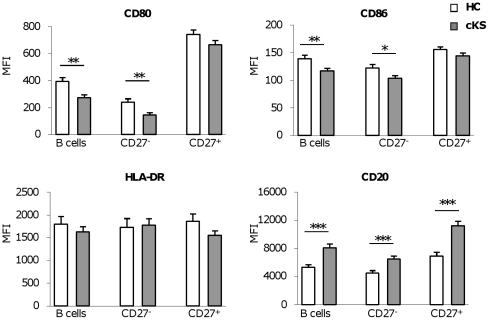
B cells from cKS patients show a low state of activation.B cells from cKS patients (grey bars) expressed lower levels of the costimulatory molecules CD80 and CD86 and higher levels of CD20 than B cells from HCs (white bars). The expression of the indicated markers on total B cells and their CD27− and CD27+ subsets is shown. Data presented as mean ± SE of mean fluorescence intensity (MFI) values. P-values calculated using the Student t test for independent samples. *P<.05; **P<.01; ***P<.001.